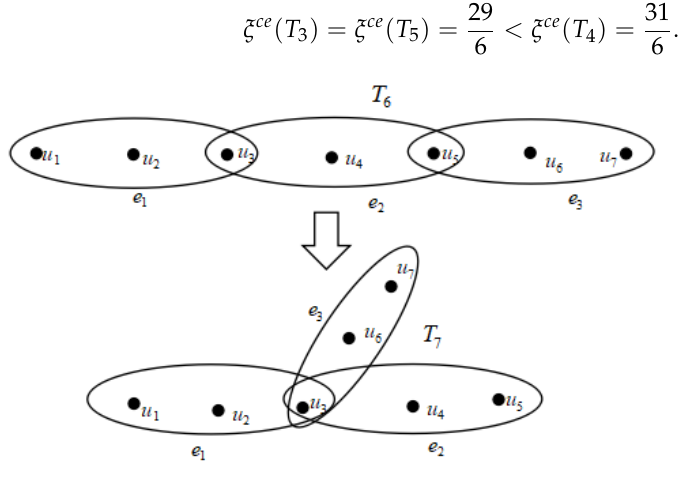
Figure 4. Transformation II on T 6